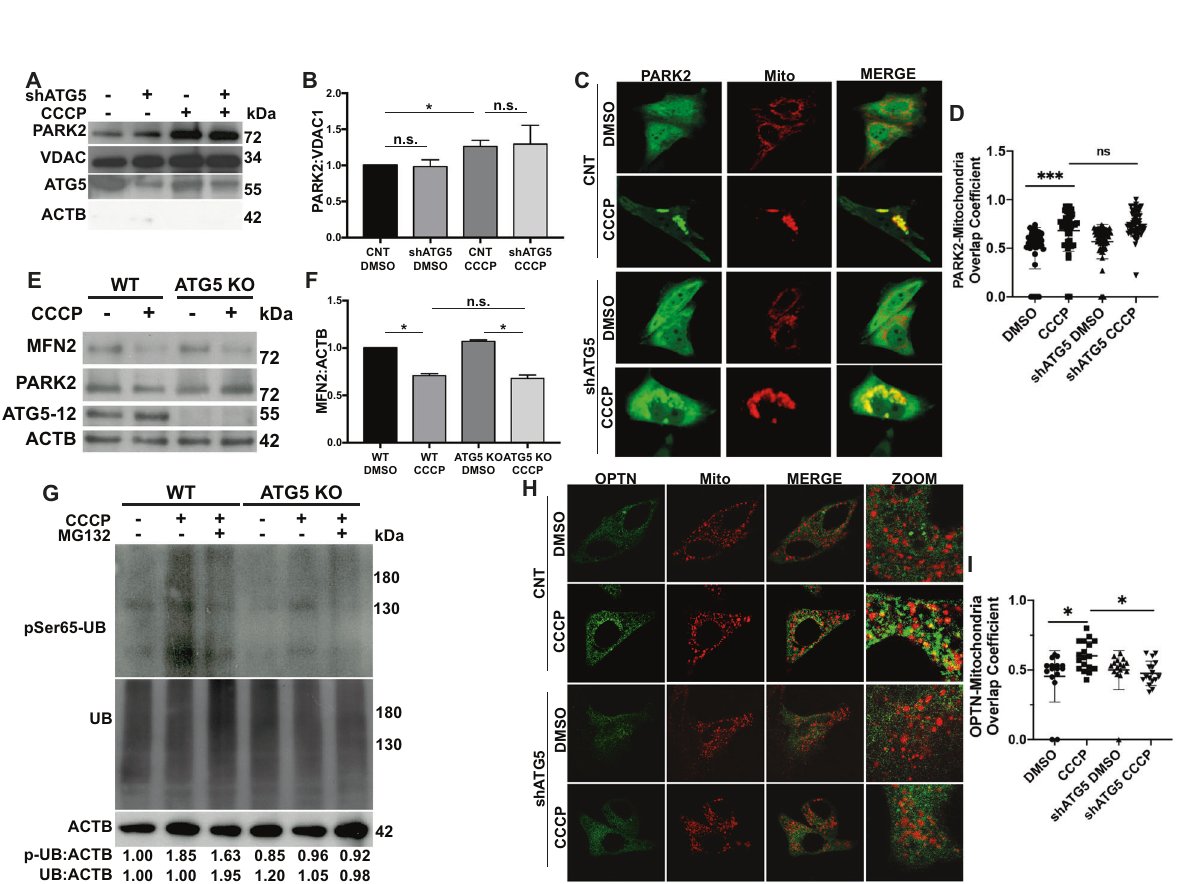
Fig. 8 ATG5 is not required for PARK2 recruitment onto mitochondria, but is indispensable for mitophagy. A, Representative western blot images of PARK2, VDAC1, ATG5-12 and ACTB in mitochondrial fractions of YFP-PARK2 expressing HEK 293 T cells transfected with control vector or ATG5 speci fi c shRNA vector (shATG5), and treated with DMSO or CCCP (10 µM) for 12 h. B Graph representing the quanti fi cation of mitochondria localized PARK2 from A (mean ± SEM, n = 3). C Representative confocal images of YFP-PARK2 (green) and mito-dsRed (red) expressing HeLa cells co-transfected with control vector (CNT) or shATG5 vector, and treated with DMSO or CCCP (10 µM) for 12 h. MERGE, overlay of green and red signals. D Graph showing colocalization coef fi ciency of PARK2 overlap with mitochondria from C (mean ± S.D., n ≥ 30, one-way ANOVA). E Representative western blot images of MFN2, PARK2, ATG5-12 and ACTB in MYC-PARK2 over expressing wild type (WT) and ATG5 knockout (KO) HeLa cells treated with DMSO or CCCP (10 µM) for 12 h. ACTB was used as loading control. F , Quanti fi cation of MFN2 levels from E (mean ± SEM, n = 3). G , Representative western blot images of phosphoSer65-ubiquitin (pSer65-UB) and total ubiquitin (UB) levels in MYC-PARK2 expressing wild type (WT) and ATG5 knockout (KO) HeLa cells treated with DMSO, CCCP (20 μ M, 2 h) or MG132 (30 μ M, 2.5 h) and CCCP (20 μ M, 2.5 h). Band intensities were marked below ( n = 3). H Confocal images of GFP-optineurin (OPTN, green) and mito- dsRed (red) expressing HeLa cells co-transfected with control vector or shATG5 vector, and treated with DMSO or CCCP (10 μ M) for 12 h. MERGE, overlay of green and red signals. ZOOM, zoomed images of particular area. I Quanti fi cation graph showing the overlap coef fi ciency values of optineurin dots (green) and mitochondria (red) from H (mean ± S.D., n ≥ 30, one-way ANOVA).